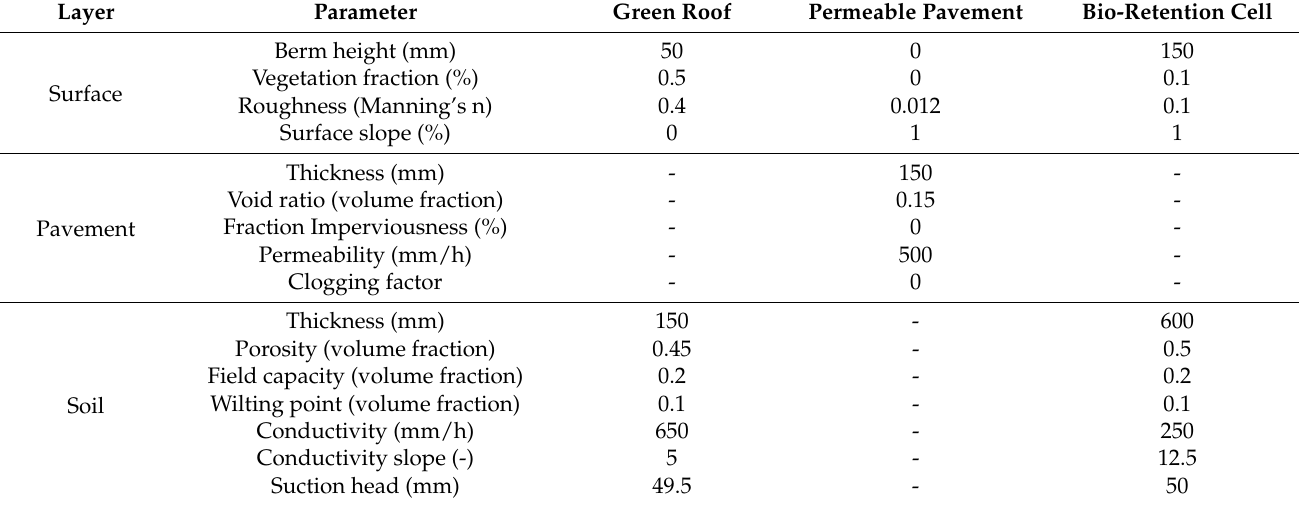
Table 1. Summary of GI characteristics. Typical values for all the parameters are based on the literature [30,32,33]. Layer Parameter Green